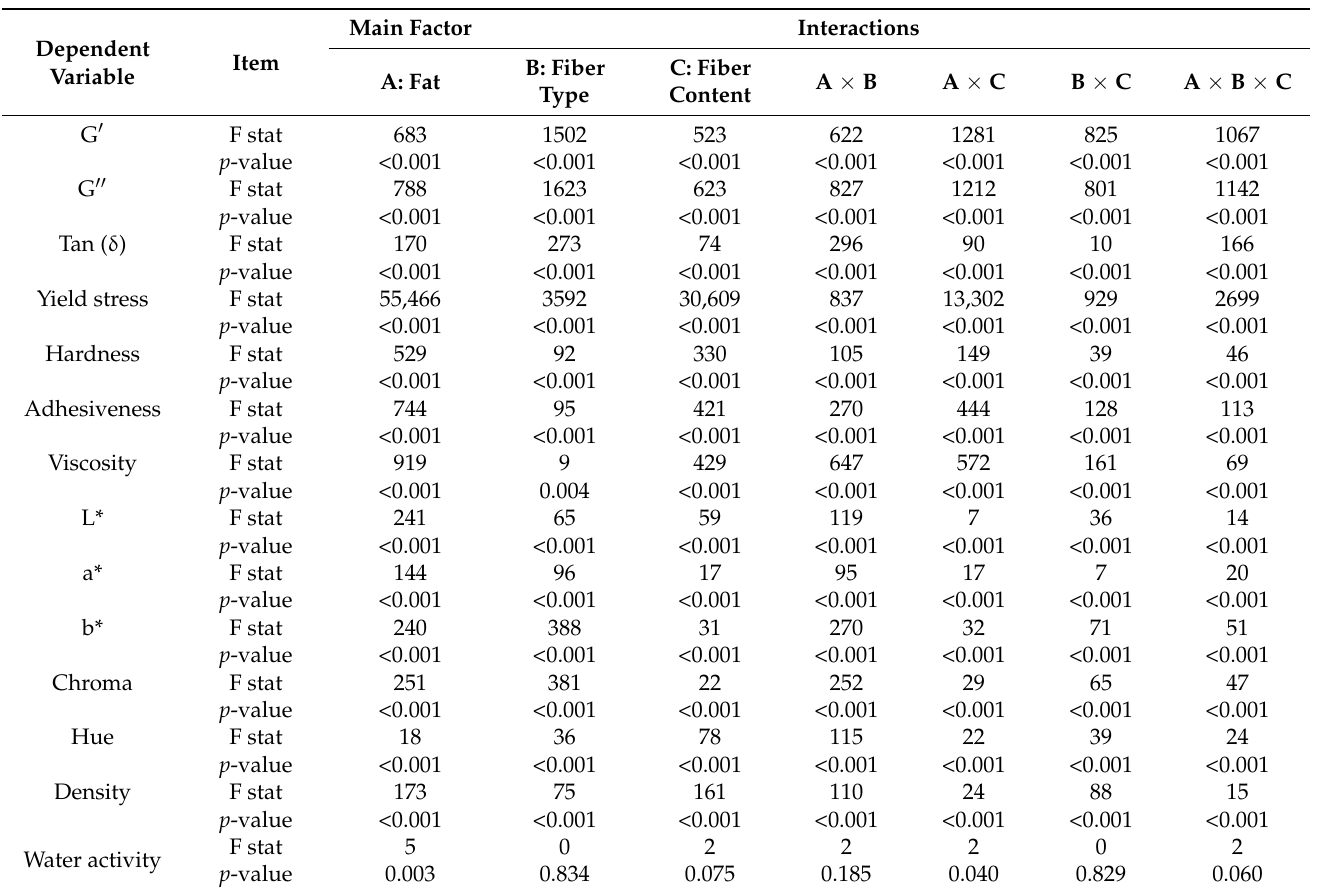
Table 1. Effects of the type of fat/oil, type of fiber and fiber concentration on physical parameters of acid casein processed cheese sauces (three-way ANOVA, F-ratio and p